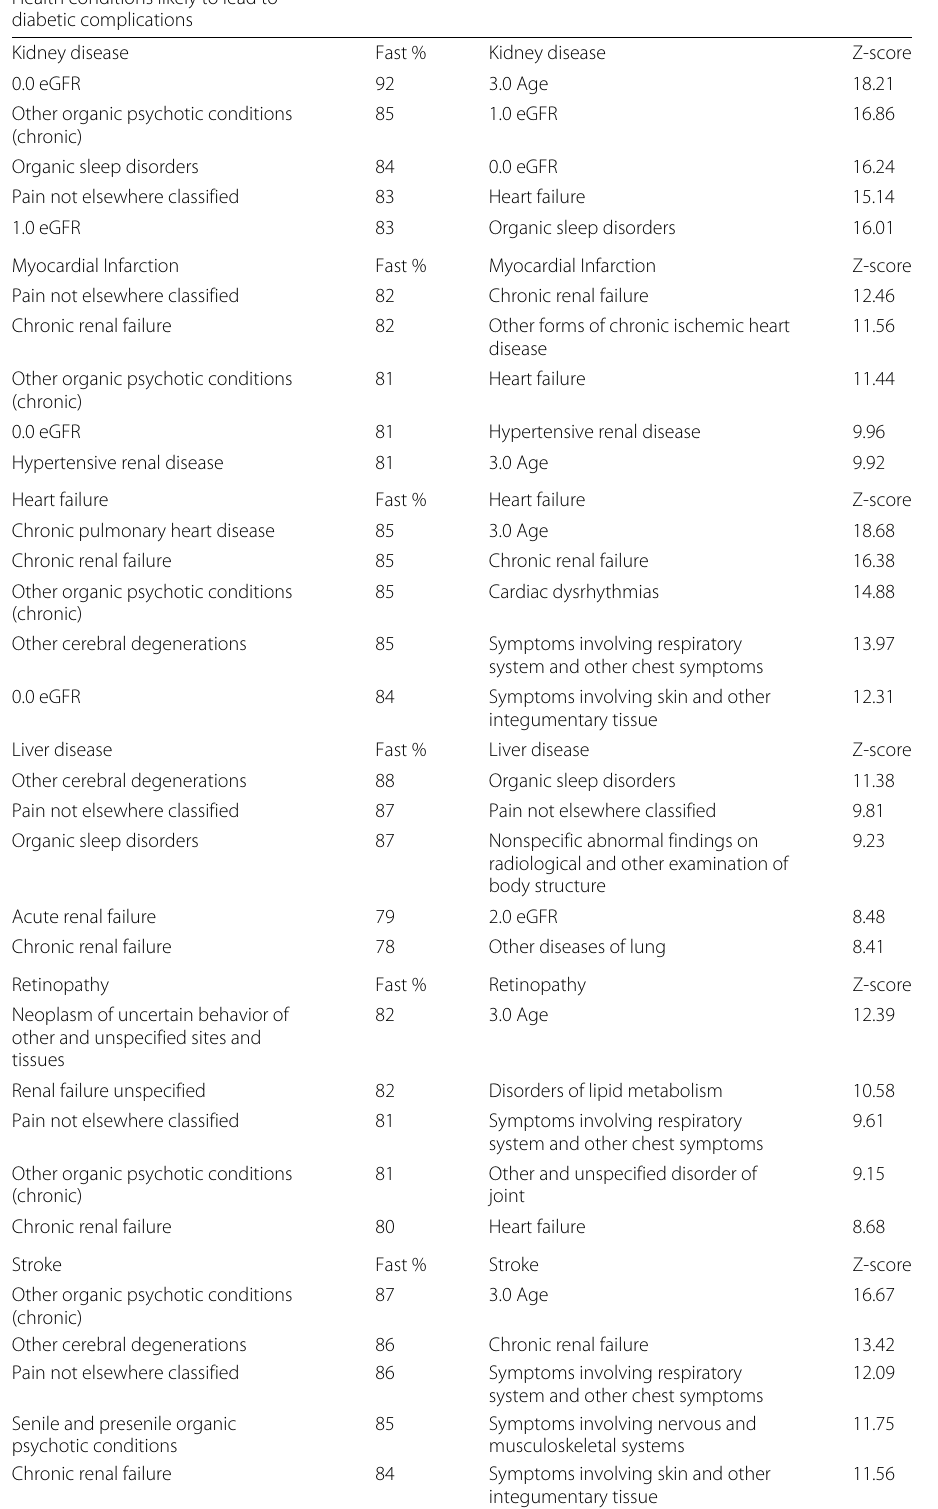
Table 7 Here we have some of the health conditions that are most likely to lead to complications based upon percentages of patients with that condition that are fast progressors, and Z-scores which correspond to the Z-test result on these particular nodes between fast and slow